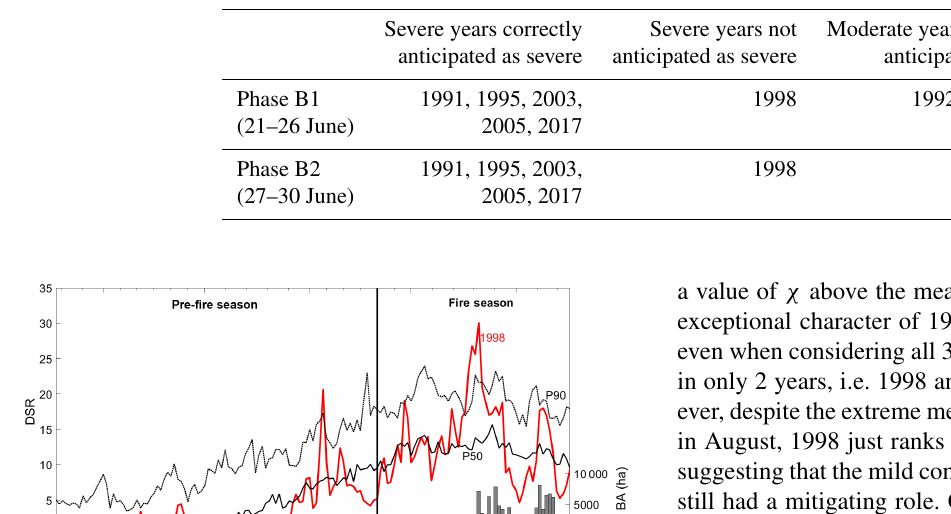
Table 4. As in Table 2 but for the model with one covariate.